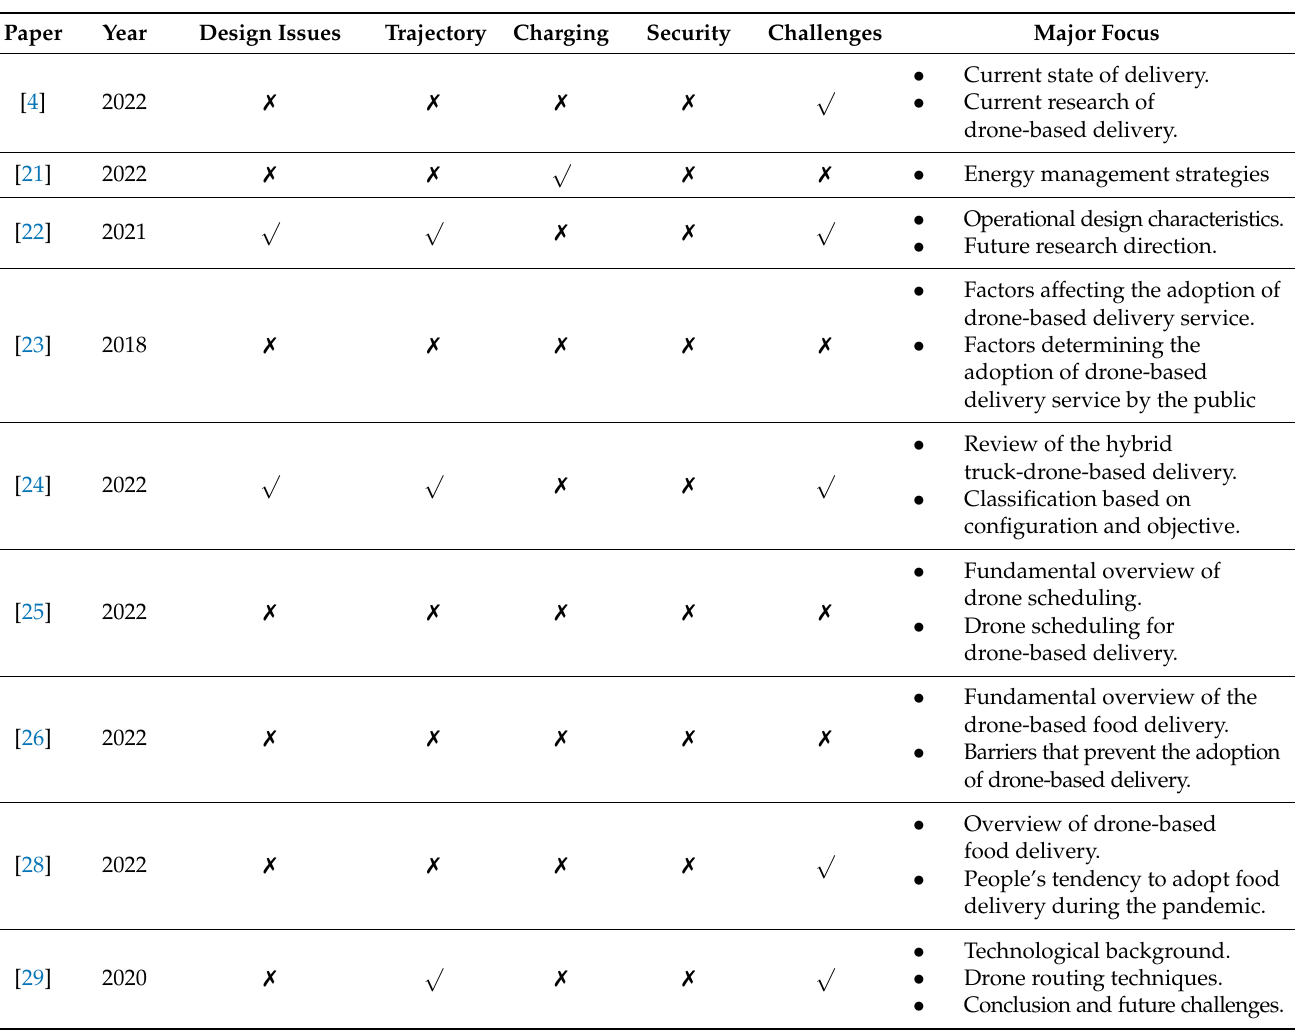
Table 1. Comparison of existing